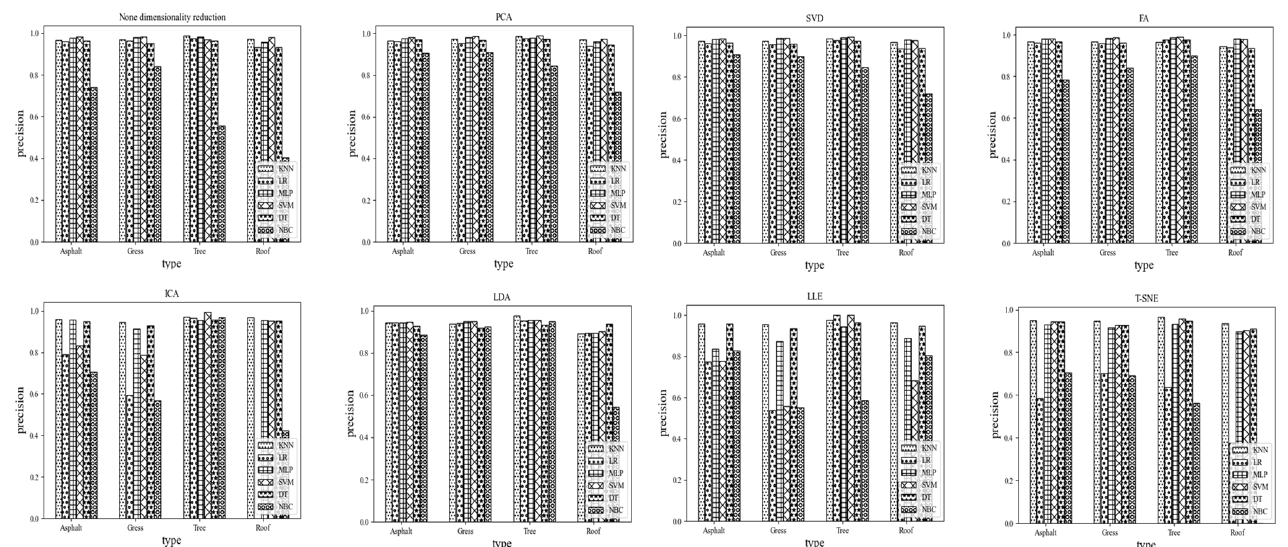
Figure 8. Comparison chart of terrain classification accuracy by different dimensionality reduction methods.